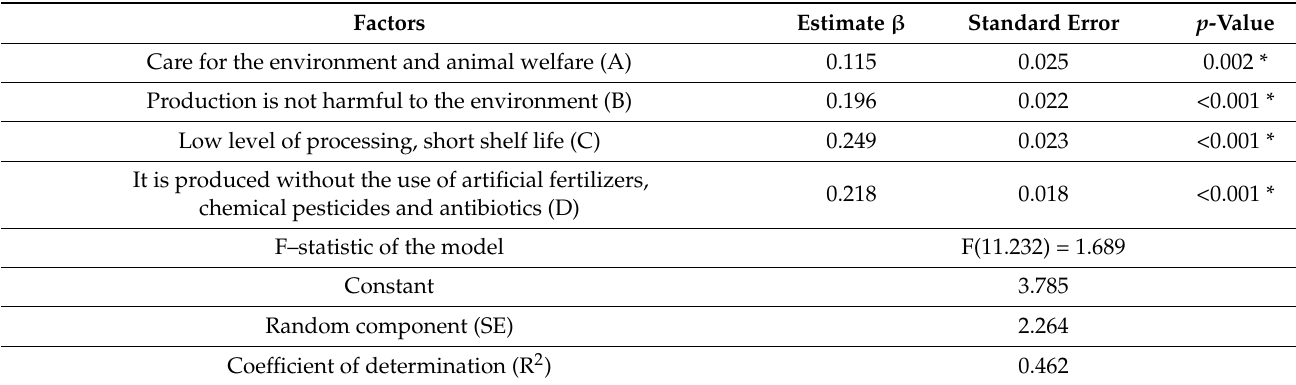
Table 4. Linear regression analysis for the variables describing the relationship between the proenvironment awareness and the tendency to buy organic